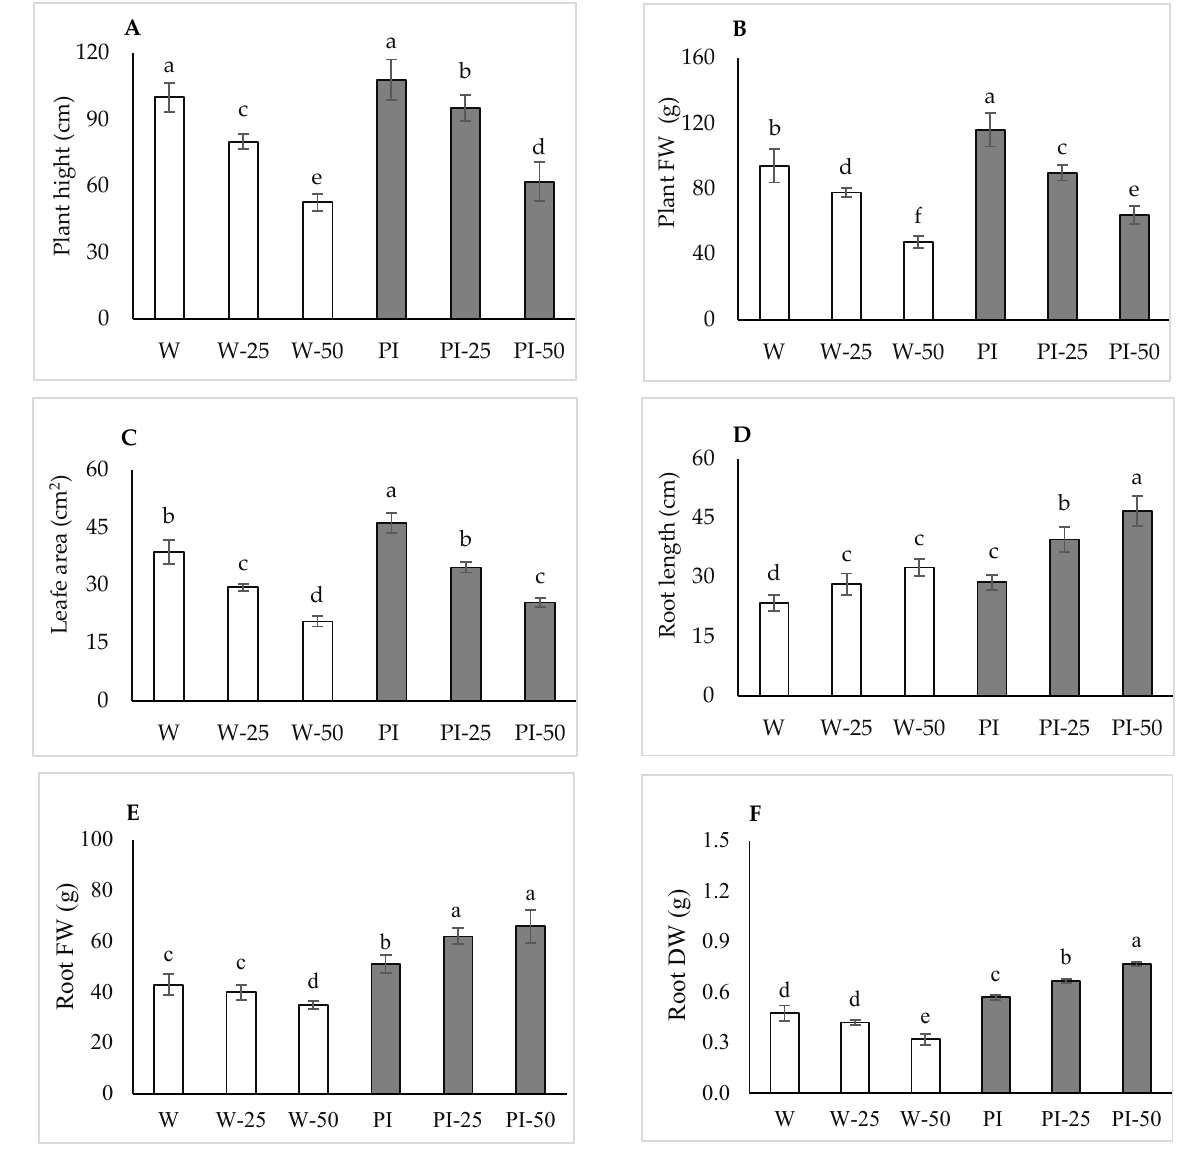
Figure 2. Impact of P. indica on growth performance of cucumber plants grown under well and limited water irrigation regimes: W (normal irrigation), W-25 (moderate water stress; equal 25% less than normal irrigation), W-50 (severe water stress; equal 50% less than normal irrigation), PI (inoculation with P. indica under normal irrigation), PI-25 (inoculation with P. indica under 25% less than normal irrigation), and PI-50 (inoculation with P. indica under 50% less than normal irrigation). ( A ) Plant height, ( B ) plant fresh weight, ( C ) leaf area, ( D ) root length, ( E ) root fresh weight, and ( F ) root dry weight. Data are means of combined analysis of two growing seasons. Means marked by the same lower-case letter are not significantly different ( p < 0.05). Error bars represent standard error of the means (SE), n = 24.